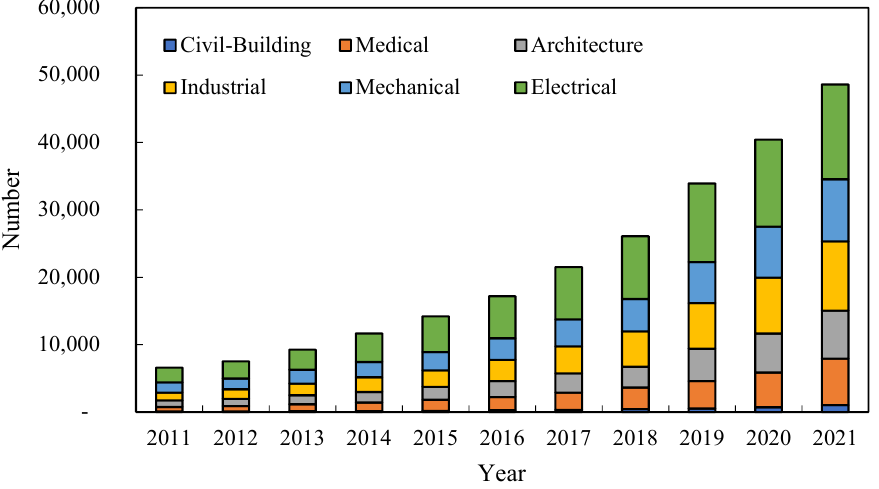
Figure 2. Number of works addressing low-cost sensors referenced in the Scopus database from 2011 to 2021 in different fields.